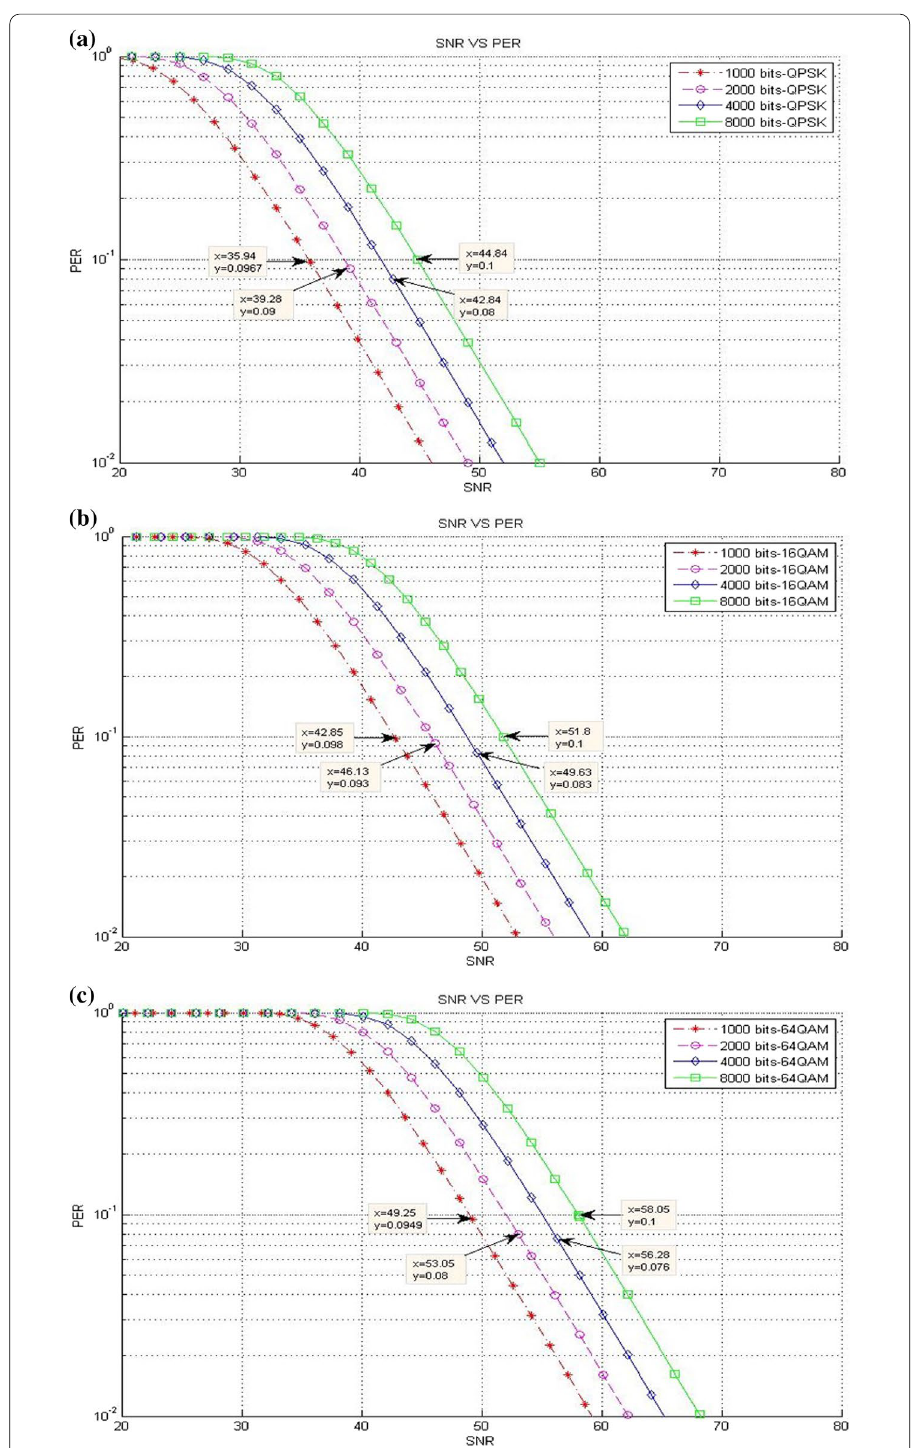
Fig. 12 a QPSK, b 16‑QAM, c 64‑QAM ( a – c ) packet loss of SNR threshold values for different modulation types and various packet sizes in the CLLA